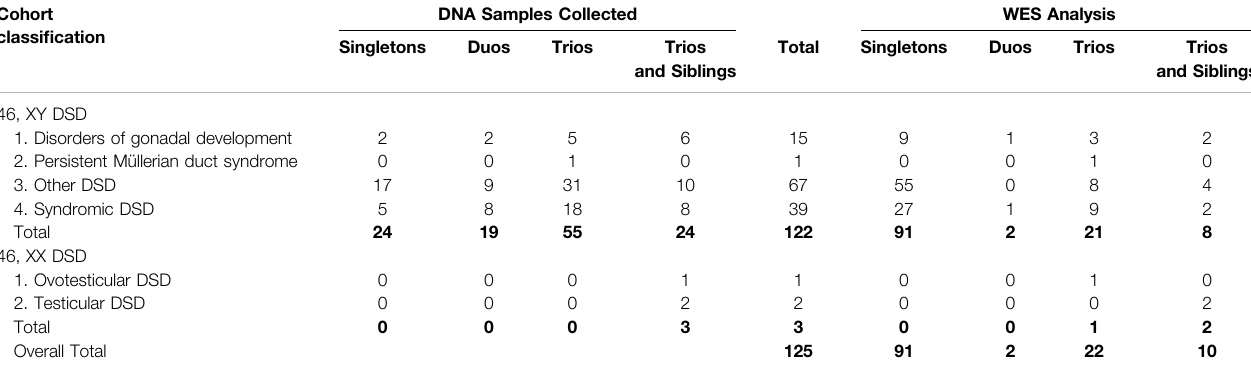
a Singletons represent affected individual only. Duos represent affected individual and one parent. Trios represent affected individual and both parents. Trios and sibling(s) represent affected individual, both parents and one sibling at least.